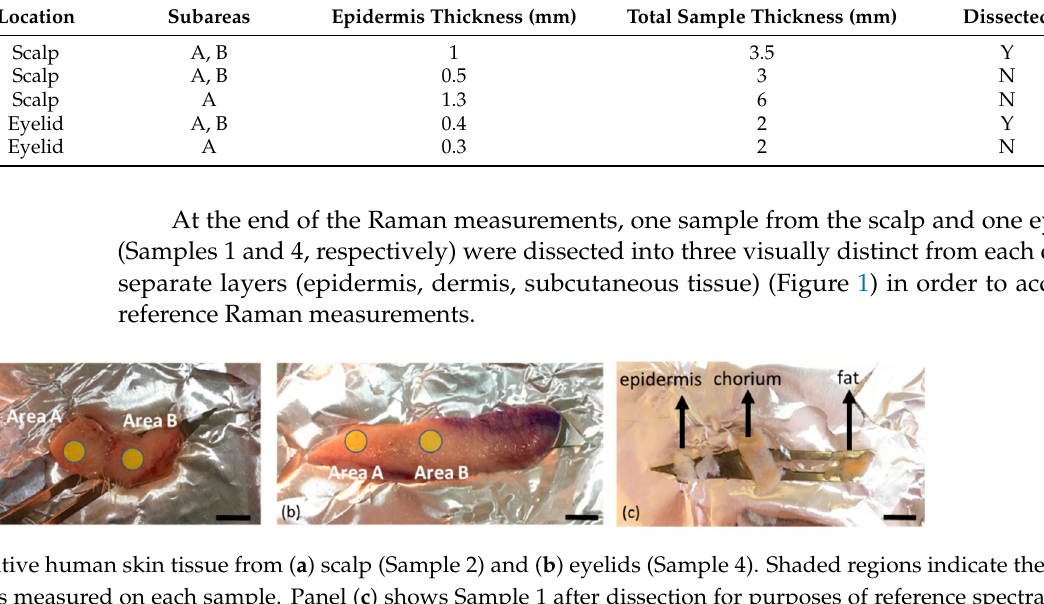
Table 1. Location and characteristics of human tissue samples employed in the study.